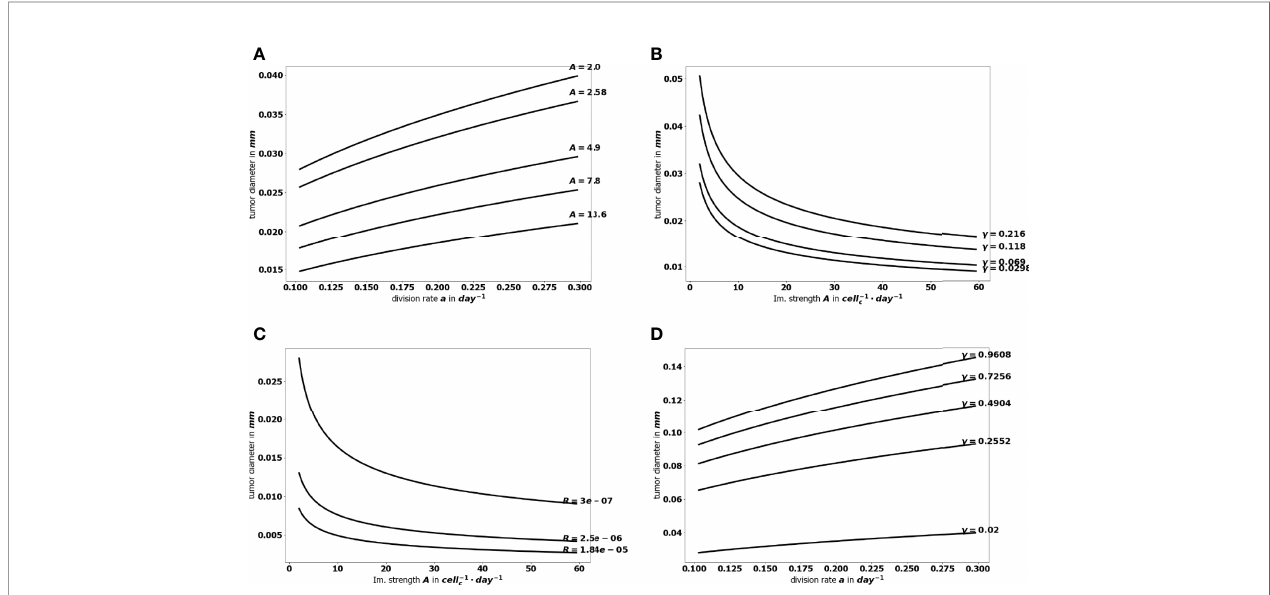
FIGURE 9 | Evolution of the tumor diameter at equilibrium, (A) with respect to the division rate a for several values of the immune strength A , (B) with respect to the immune strength A for several values of the death rate g , (C) with respect to the immune strength A for several values of the in fl ux rate of effector immune cells R +, and (D) with respect to the division rate a for several values of the death rate g